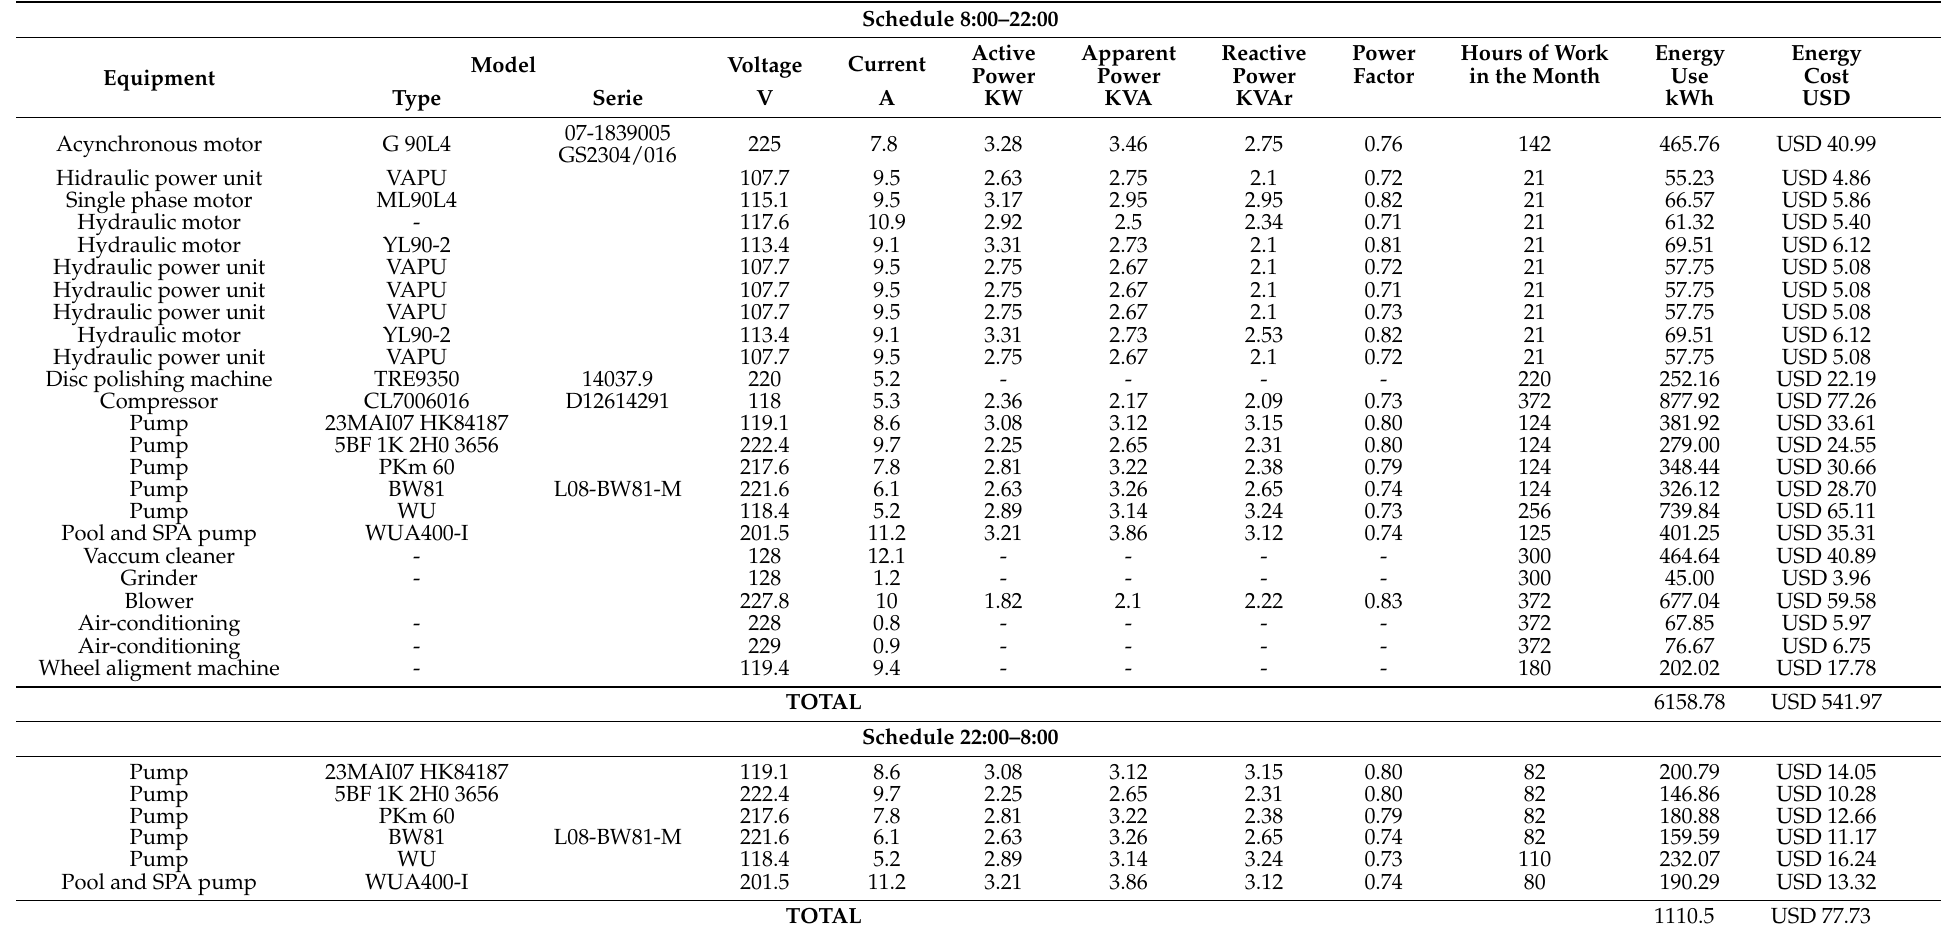
Table A4. Inventory of